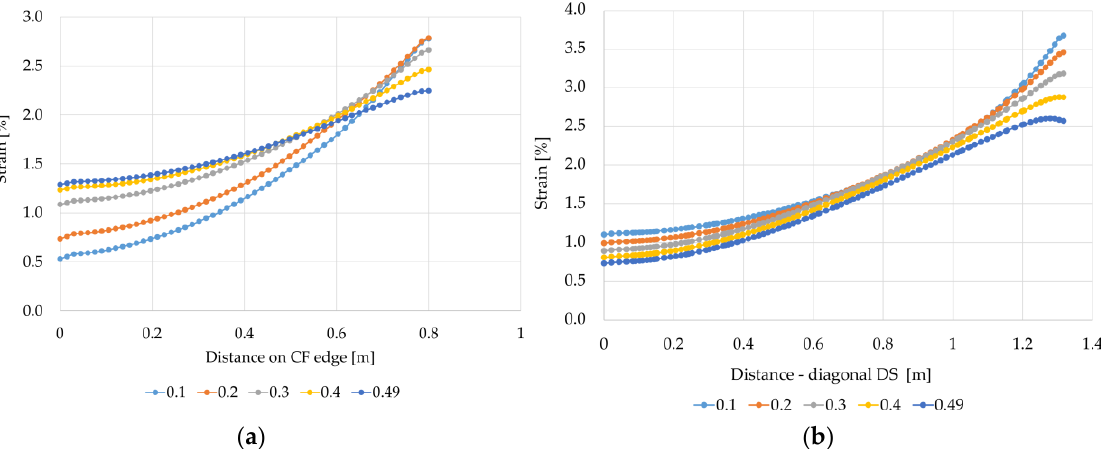
Figure 18. Graphs of membrane strains depending on the Poisson’s ratio value—variant B1: ( a ) on the edge CF; ( b ) on the diagonal DS.